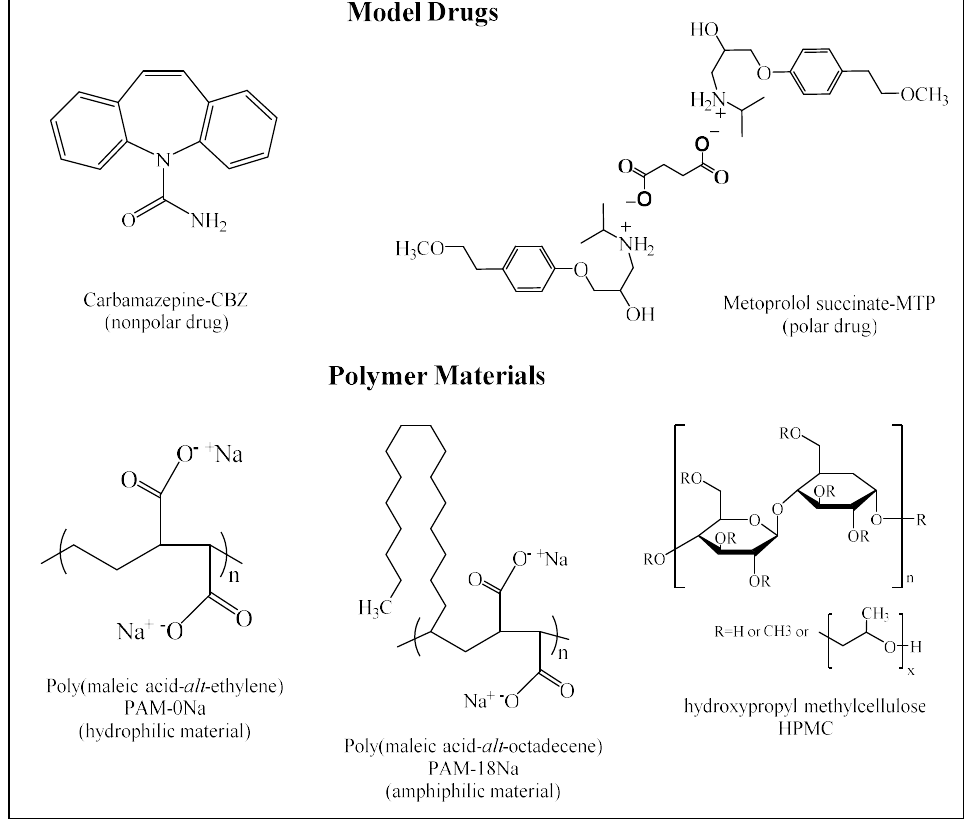
Figure 1. Chemical structure of the Carbamazepine and Metoprolol (model drugs), the polyelectrolyte materials derived from maleic anhydride and the reference polymer hydroxypropyl-methyl cellulose (HPMC).